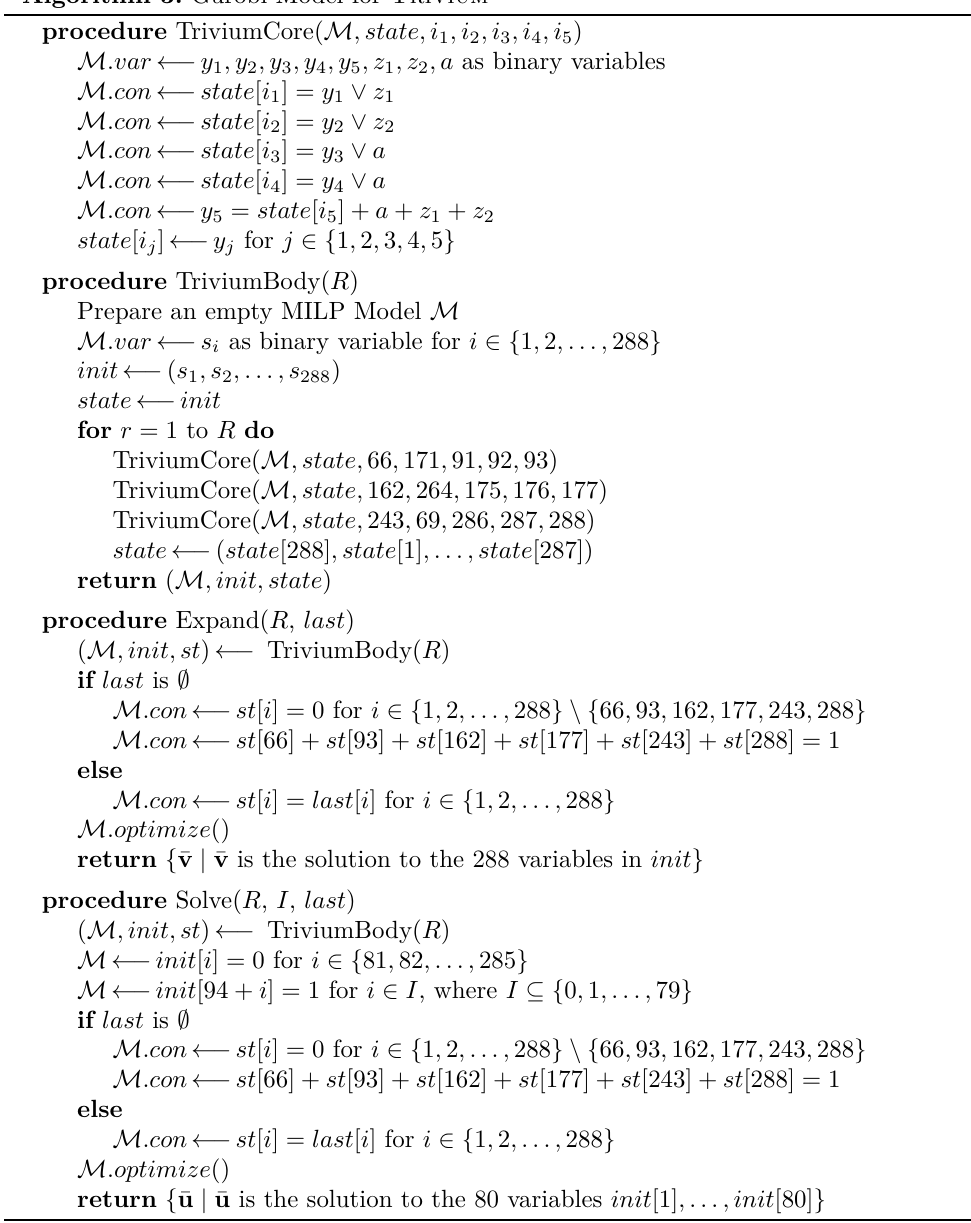
Algorithm 3: Gurobi Model for